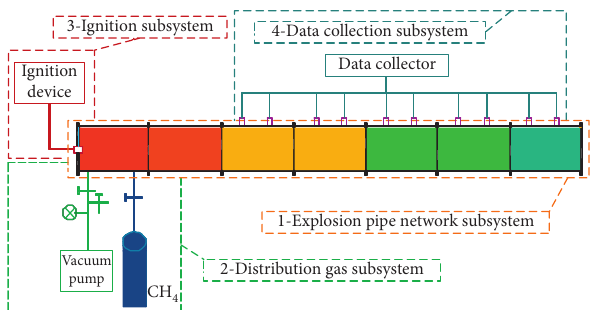
Figure 7: Components of gas explosion experimental system.